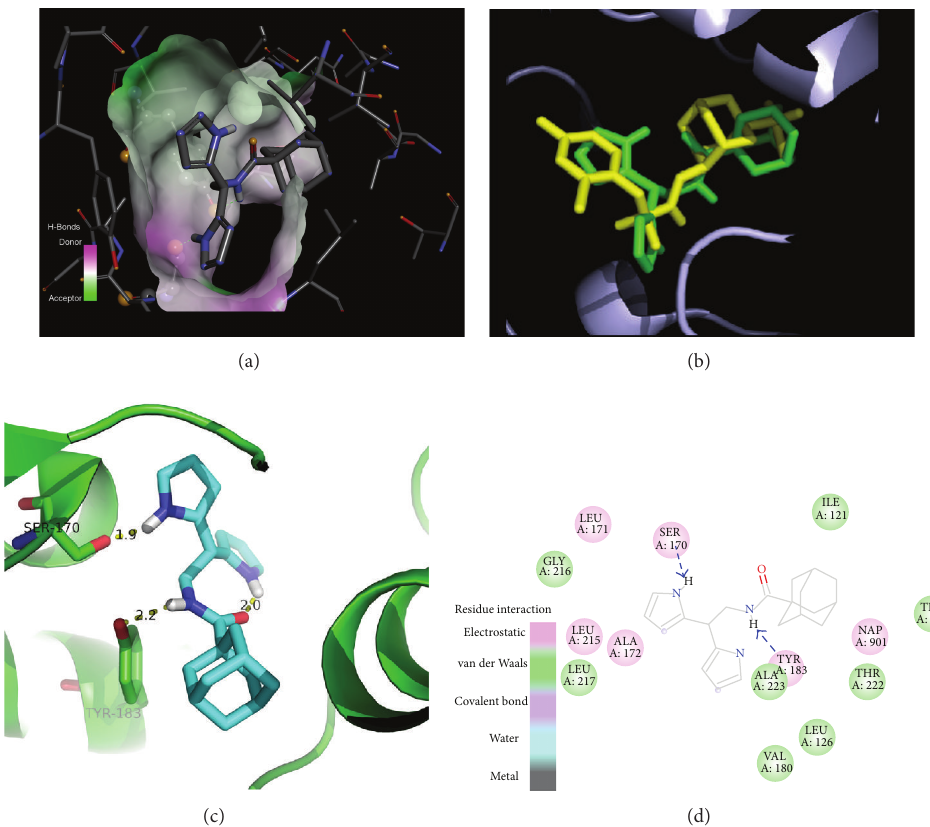
Figure 3: (a) Compound 1 docked in the active site. (b) Comparison of compound 1 and 2-(2-chloro-4-fluorophenoxy)-2-methyl- N - [(1 R ,2 S ,3 S ,5 S ,7 S )-5-(methylsulfonyl)-2-adamantyl]propanamide after docking. (c) Hydrogen bonding interactions between compound 1 and the amino acid residues Ser 170 an TYR 183. (d) Binding pocket of compound 1 .